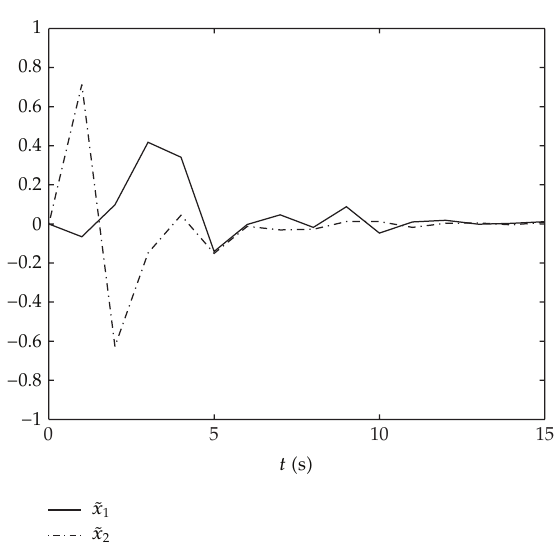
Figure 3: The error response (cid:18) x (cid:3) k (cid:4)